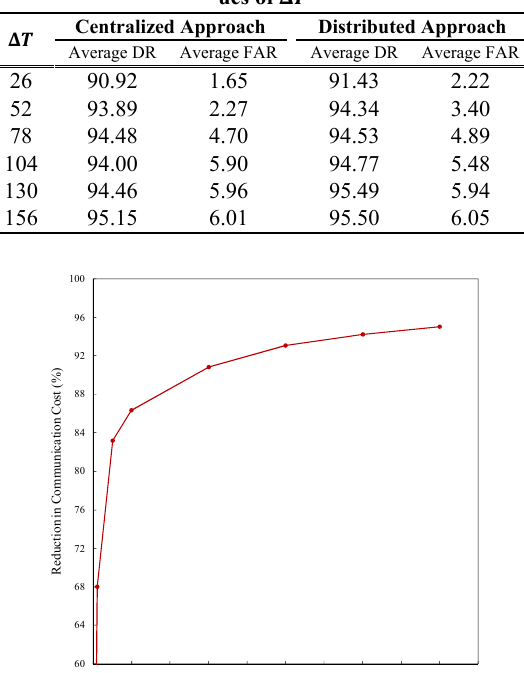
Table 4. Average detection and false alarm rates of the